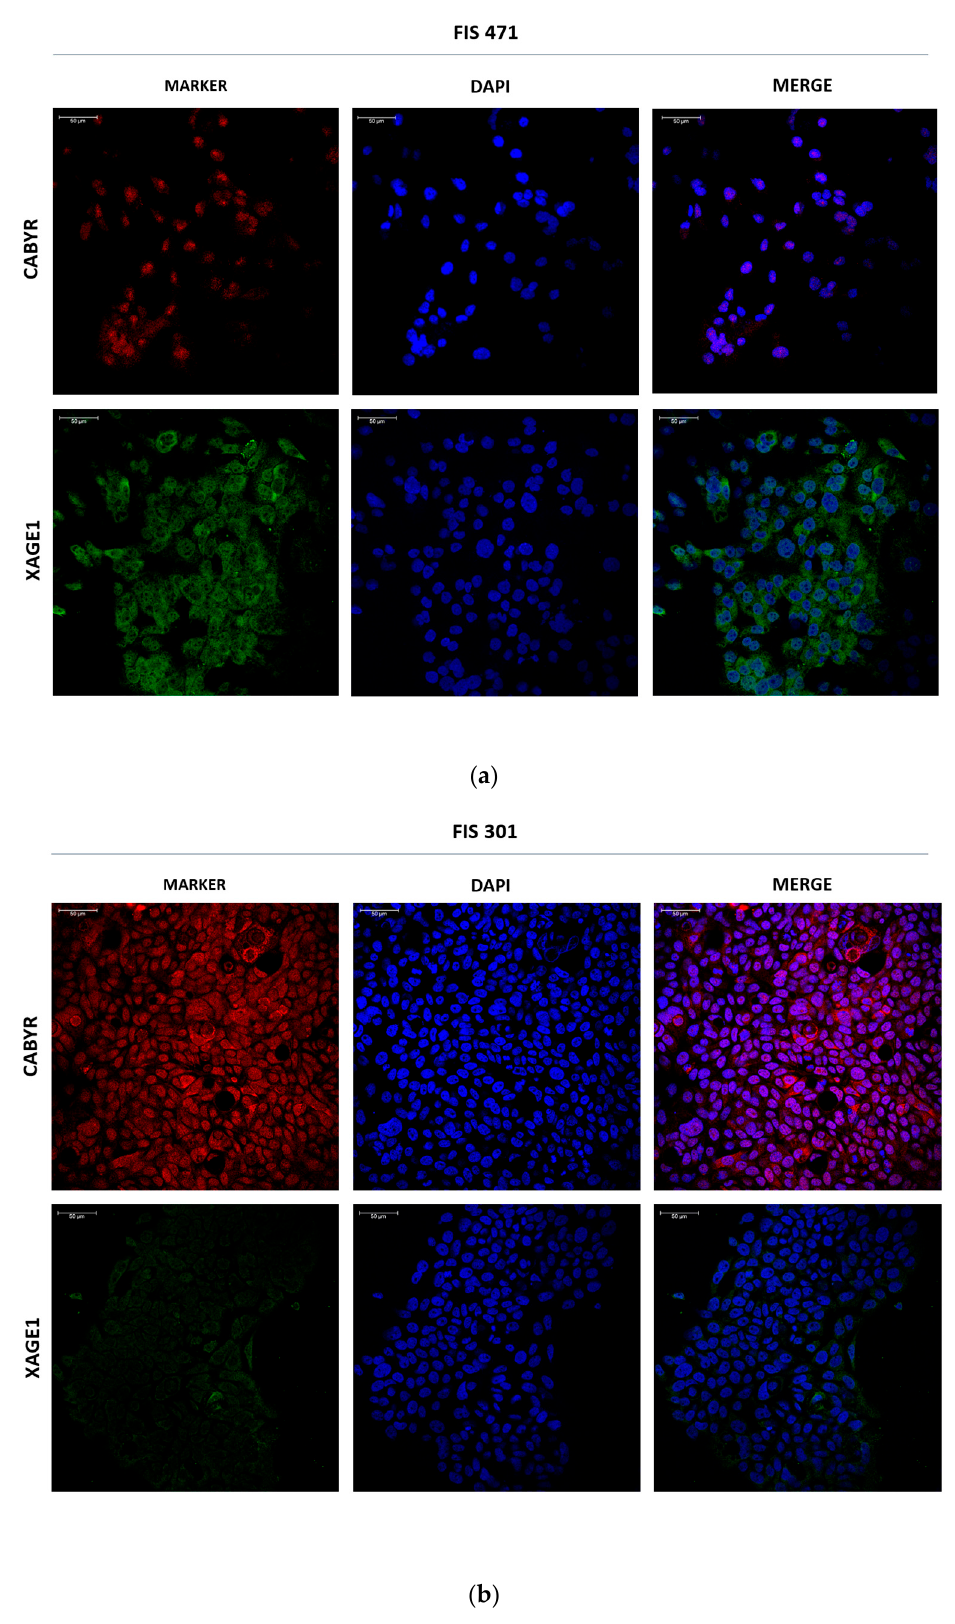
Figure 6. Immunofluorescent staining of CABYR and XAGE1 in primary cultures. ( a ) Representative images of CABYR (red) and XAGE1B (green) in adherent-cultured cells from FIS 471 (LUAD). ( b ) Representative images of CABYR (red) and XAGE1B (green) in adherent-cultured cells from FIS 301 (LUSC). Cell nuclei are stained with DAPI (blue). Scale bar represents 50 µ